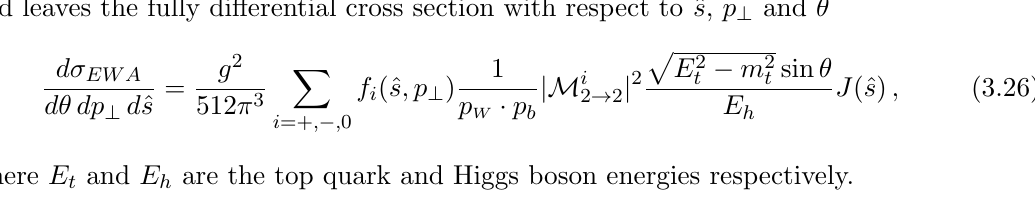
Figure 2. Plot of the splitting functions for the equivalent W emission as a function of the hard-scattering energy fraction y = p ^ s= 2 E for three di(cid:11)erent values of R = m and leaves the fully di(cid:11)erential cross section with respect to ^ s , p